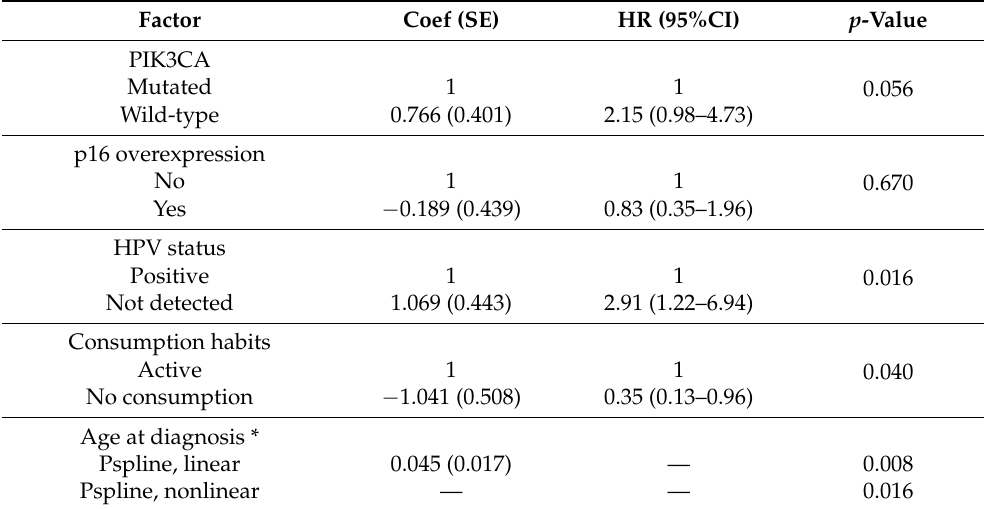
Table 5. Multivariable analysis of the PIK3CA mutation and p16 status association with overall survival, Cox regression model adjusted for HPV status, alcohol/tobacco consumption habits, and age at